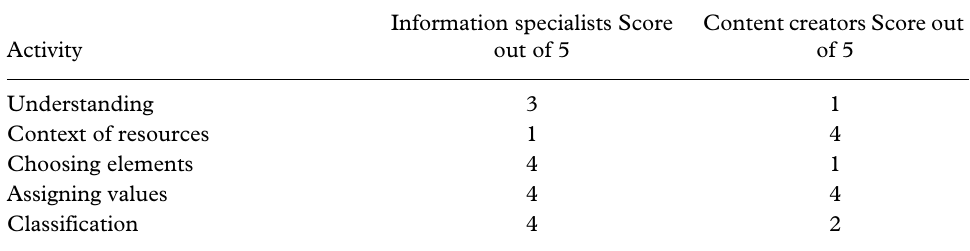
Table 3. Comparative assessment of success in creating